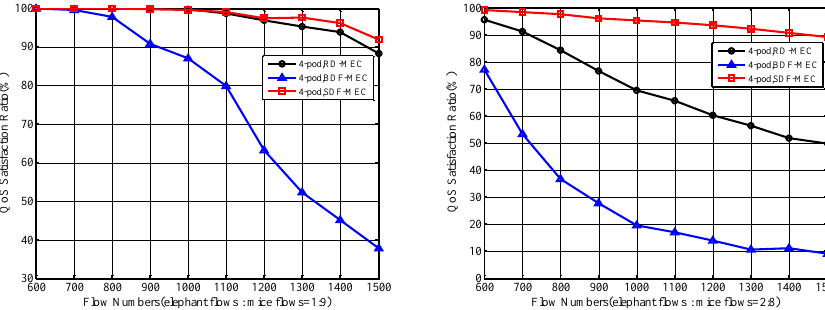
Figure 4. QoS satisfaction ratio of Random-order Demand Minimum Energy Consumption (RD-MEC), Biggest Demand First Minimum Energy Consumption (BDF-MEC), and Smallest Demand First Minimum Energy Consumption (SDF-MEC) in 4-pod Fat-Tree.